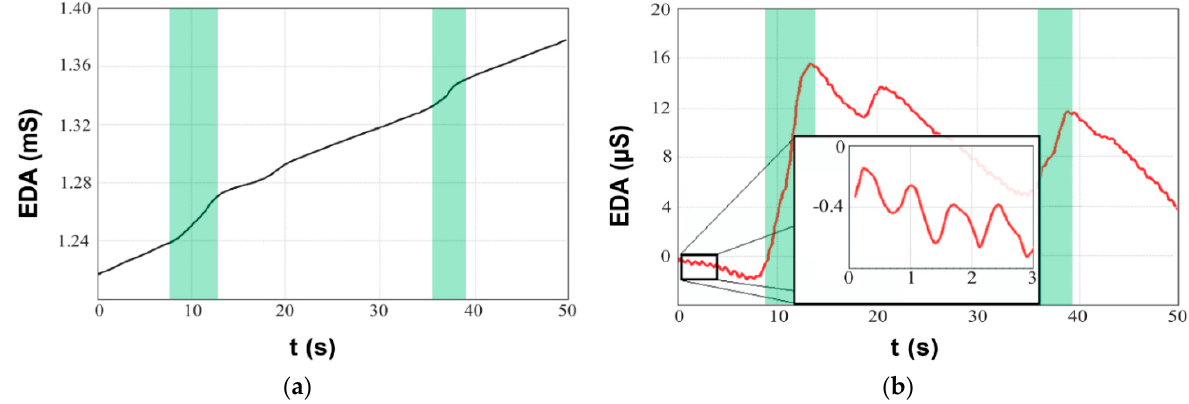
Figure 3. EDA obtained using IDA microelectrodes: ( a ) tonic component, ( b ) extracted phasic component with small variations due to blood pulse wave.